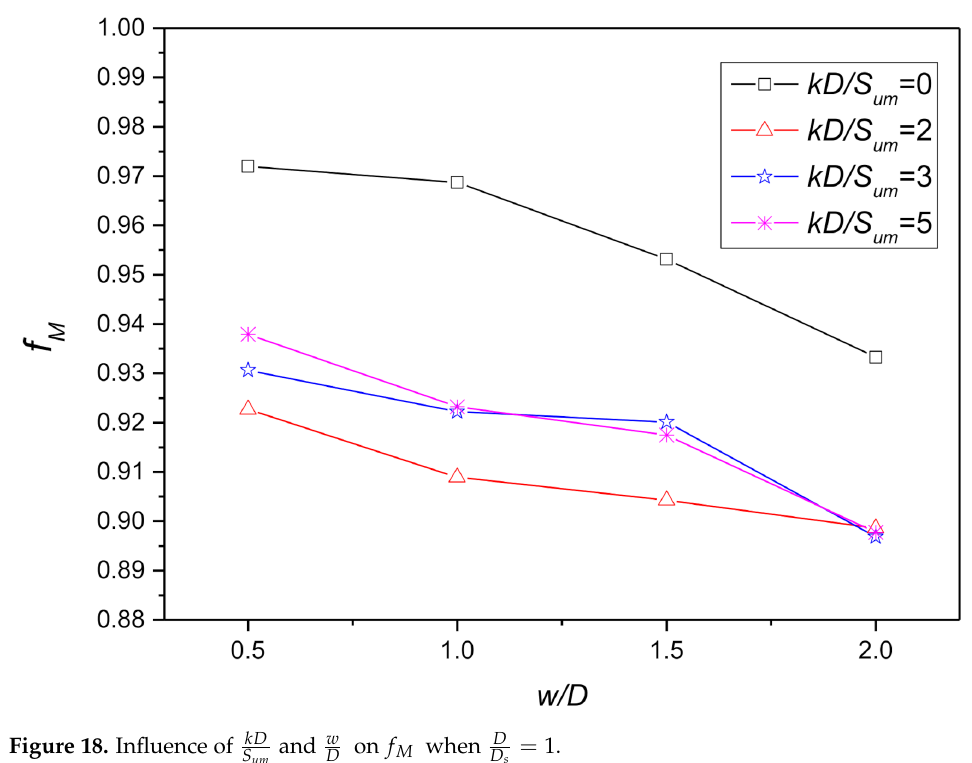
and w on f M when D D S um